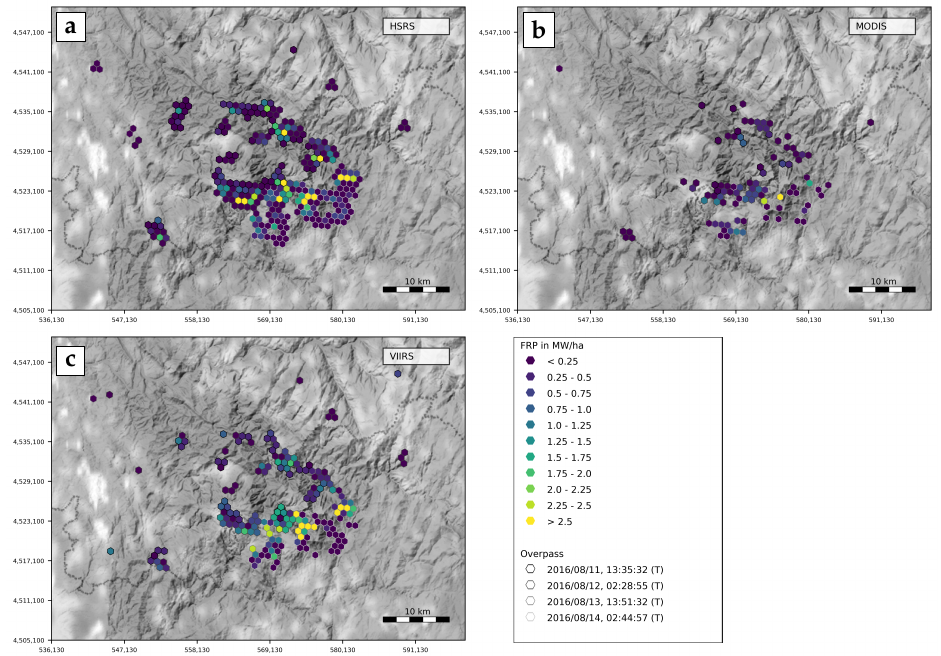
Figure 3. FireBIRD active fire data (derived using the MWIR method) and reference data for a fire event in northern Portugal, August 2016. ( a ) shows active fires derived from four Fire- BIRD/HSRS overpasses (11–14 August 2016), pigmented by FRP. ( b ) shows MODIS active fire data of the Aqua/Terra overpasses in closest temporal vicinity to the respective FireBIRD overpasses. ( c ) shows VIIRS active fire data of the Suomi-NPP overpasses in closest temporal vicinity to the respective FireBIRD overpasses. Background: Stamen/OpenStreetMap shaded terrain map, shown in gray